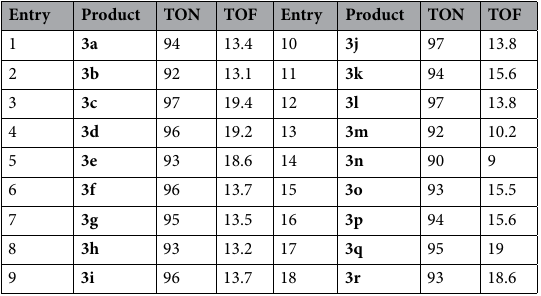
Table 4. Calculated turnover number (TON) and turnover frequency (TOF).